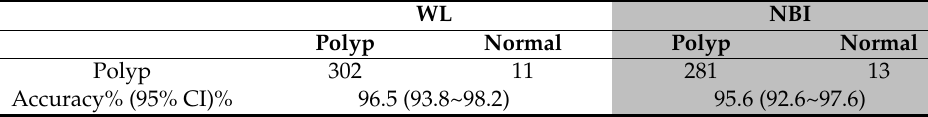
Table 13. Polyp > 0.5 cm.